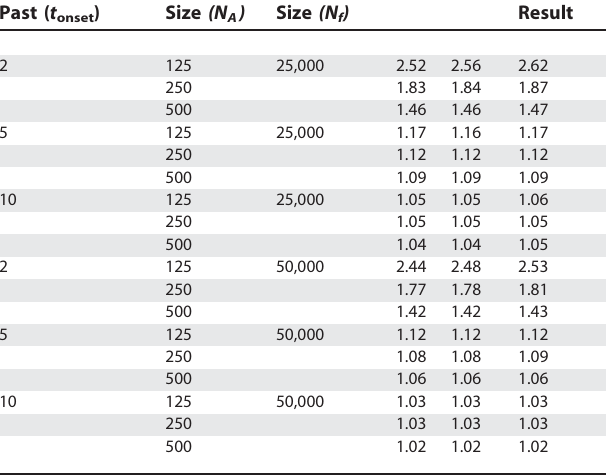
Table 2. Values of the Inflation Factor in Very Recently Expanded Populations